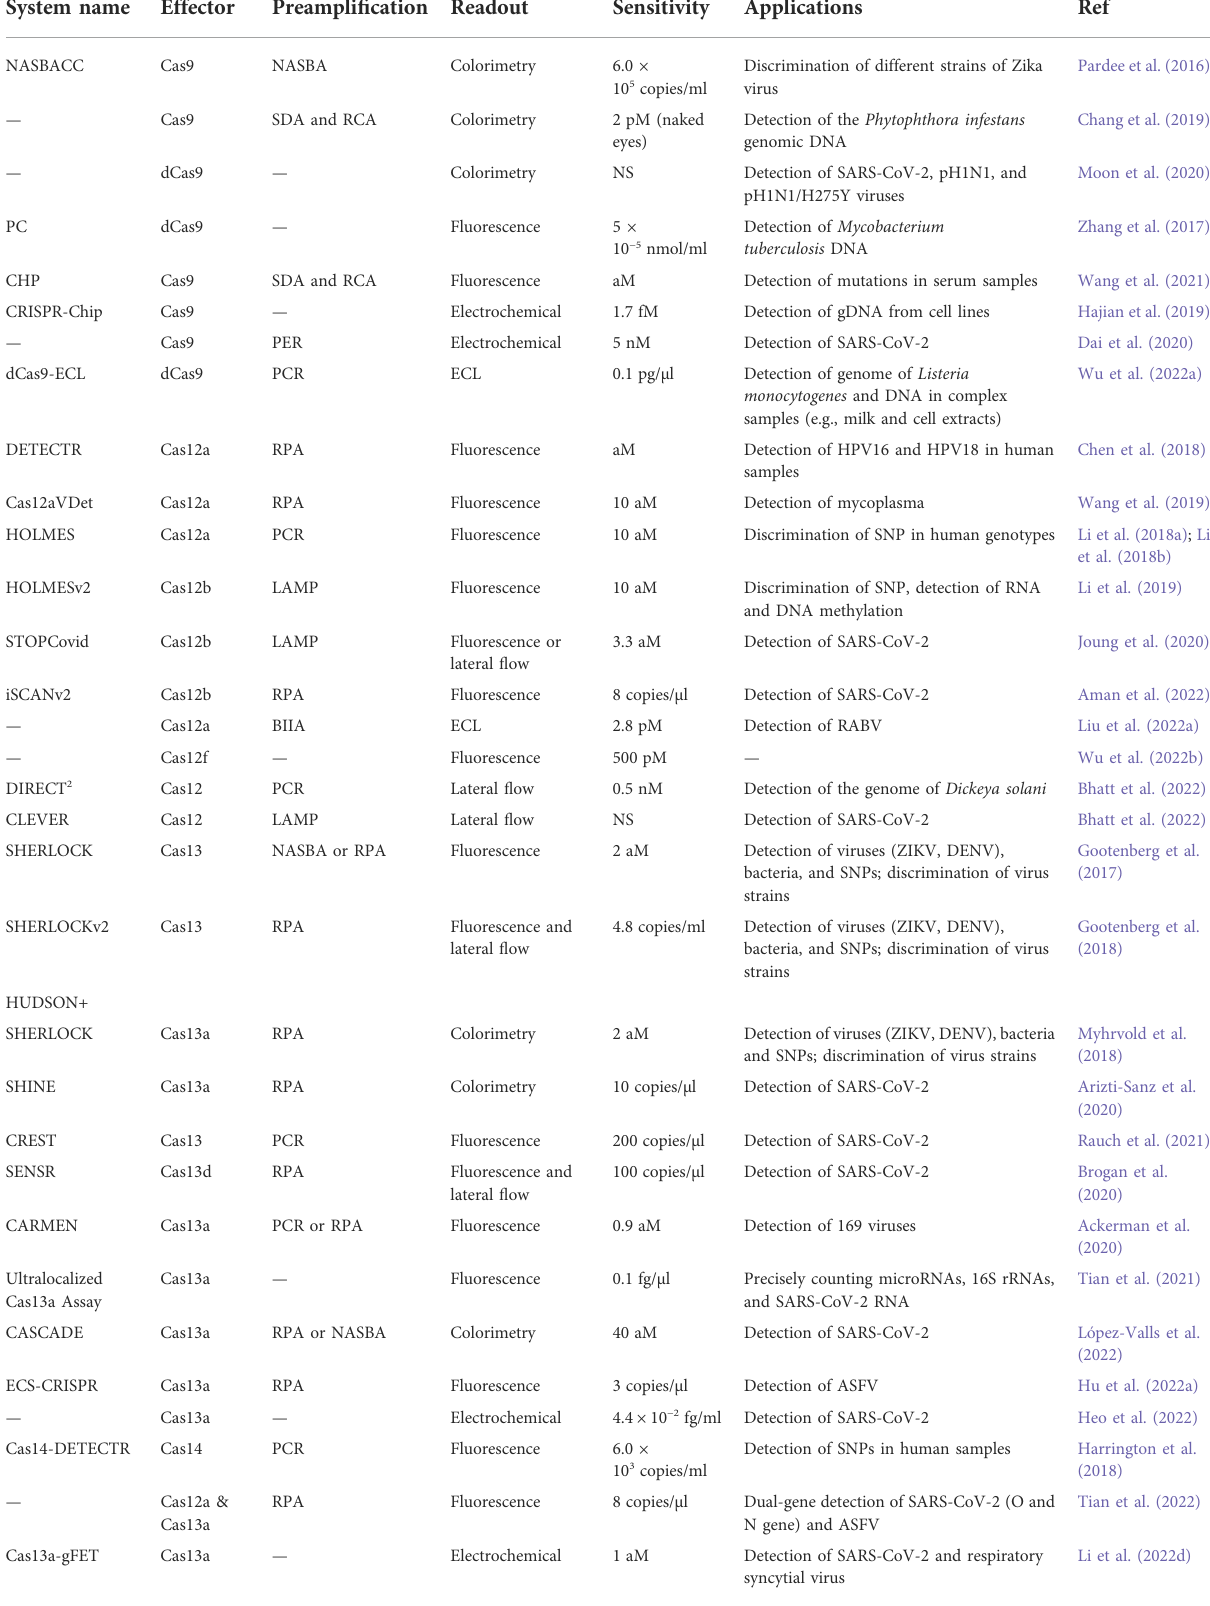
TABLE 1 Characteristics of CRISPR-based biosensors for molecular